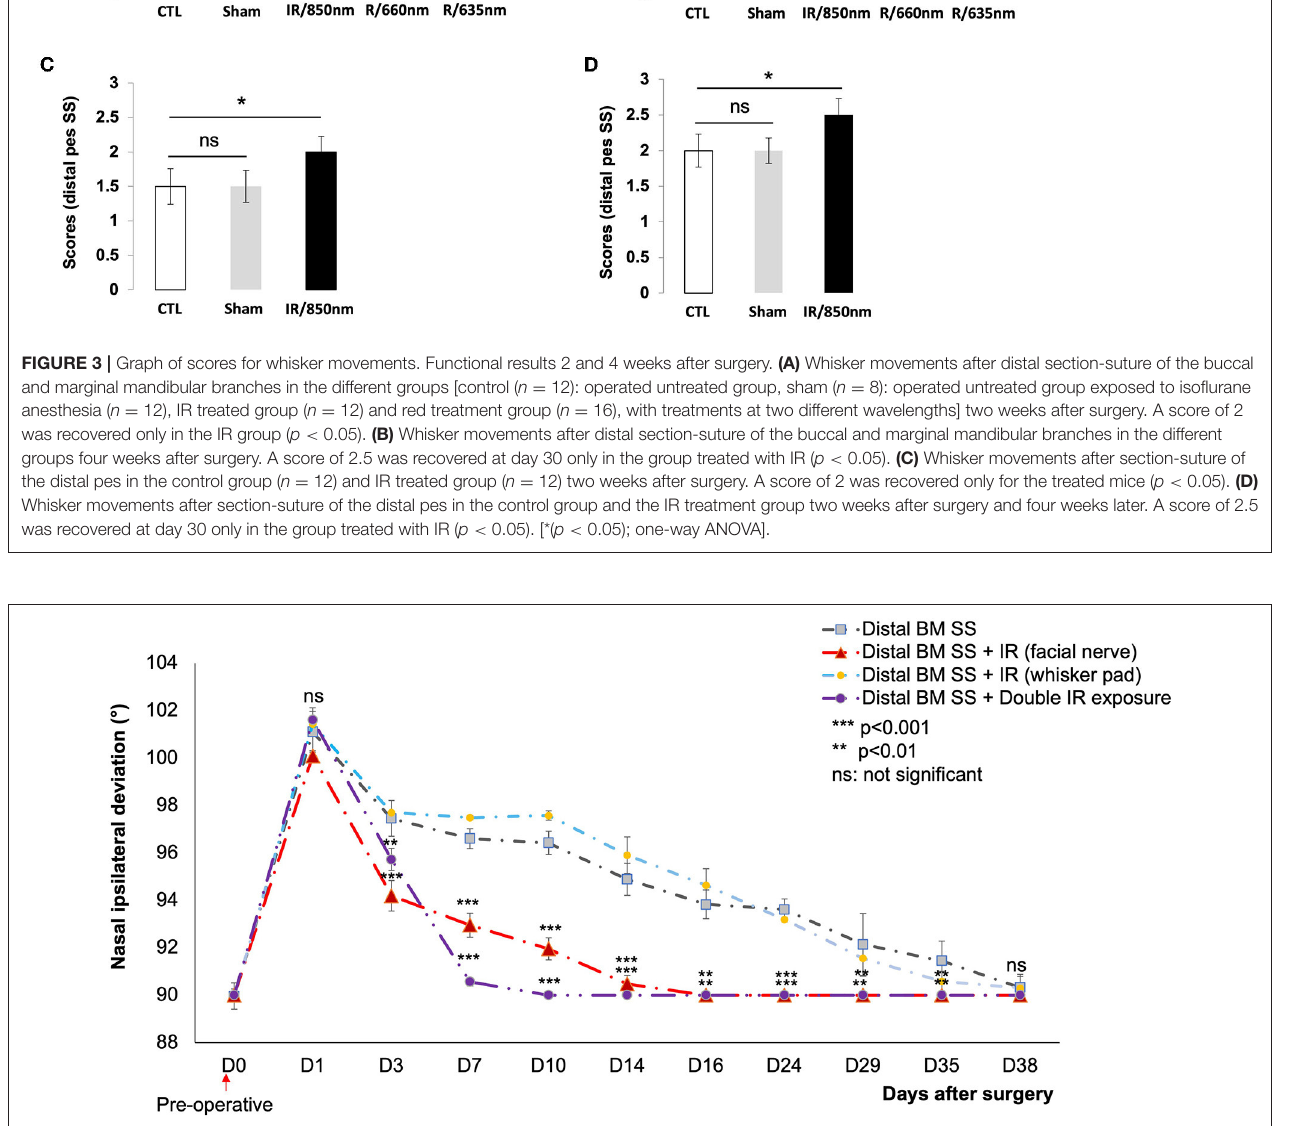
Frontiers in Neurology |